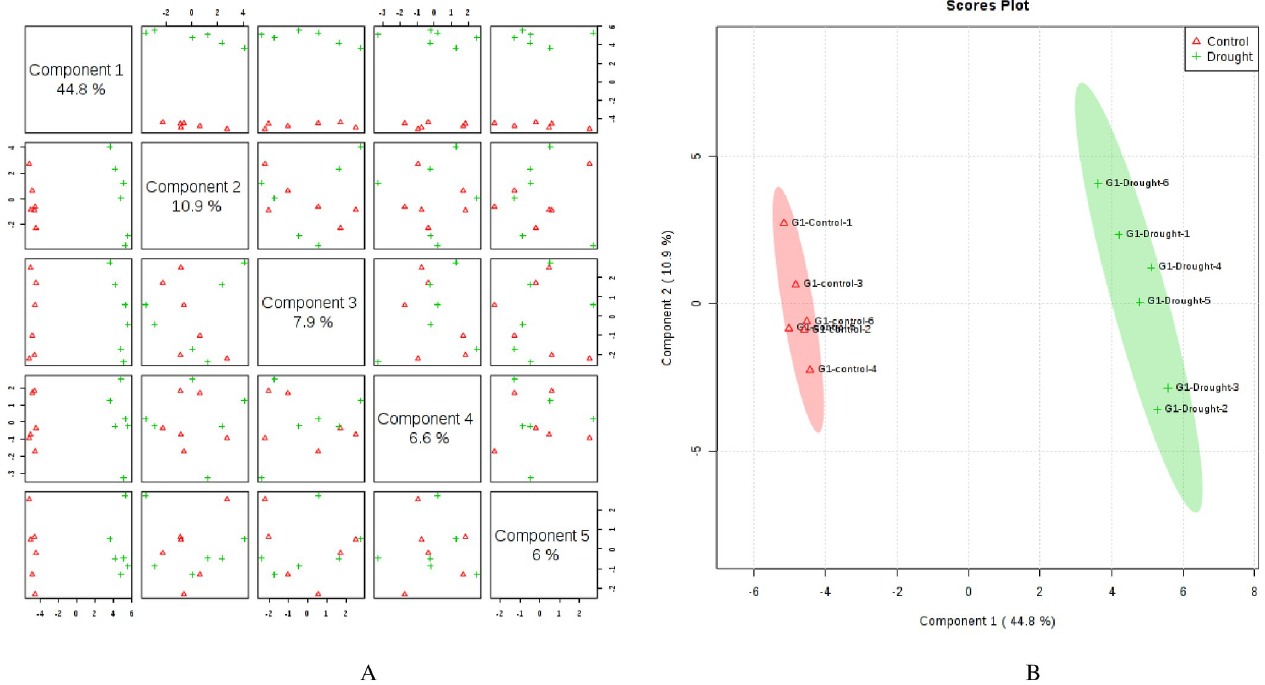
Fig 2. Partial least square discriminant analysis (PLS-DA) (A) and 2D Scores plot (B) in roots of LA754 under control (irrigated) and drought conditions. Samples at control and drought treatments did not overlap with each other indicating an altered state of metabolite levels in the wheat roots.